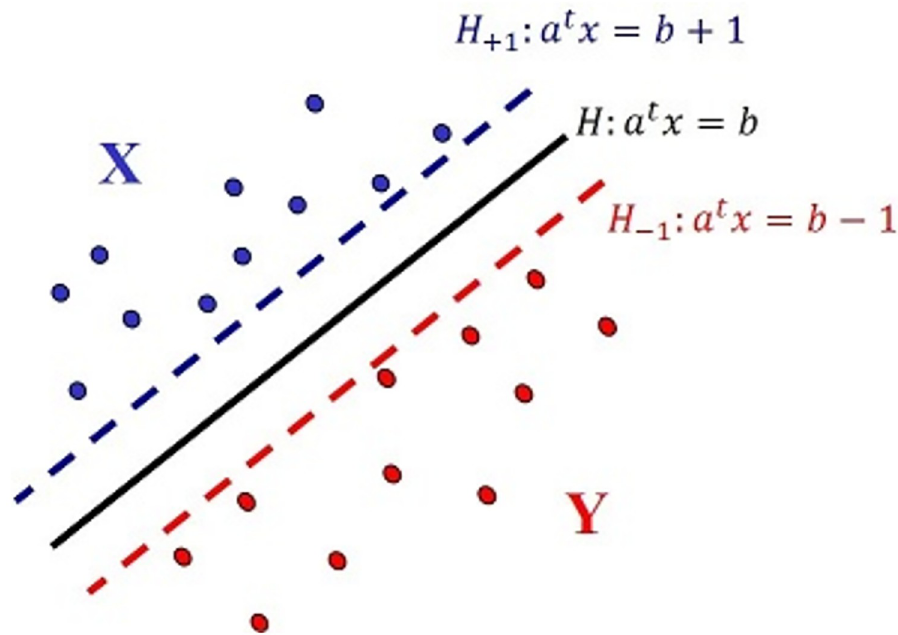
Fig 2. Situation of X and Y related to H , H +1 and H − 1